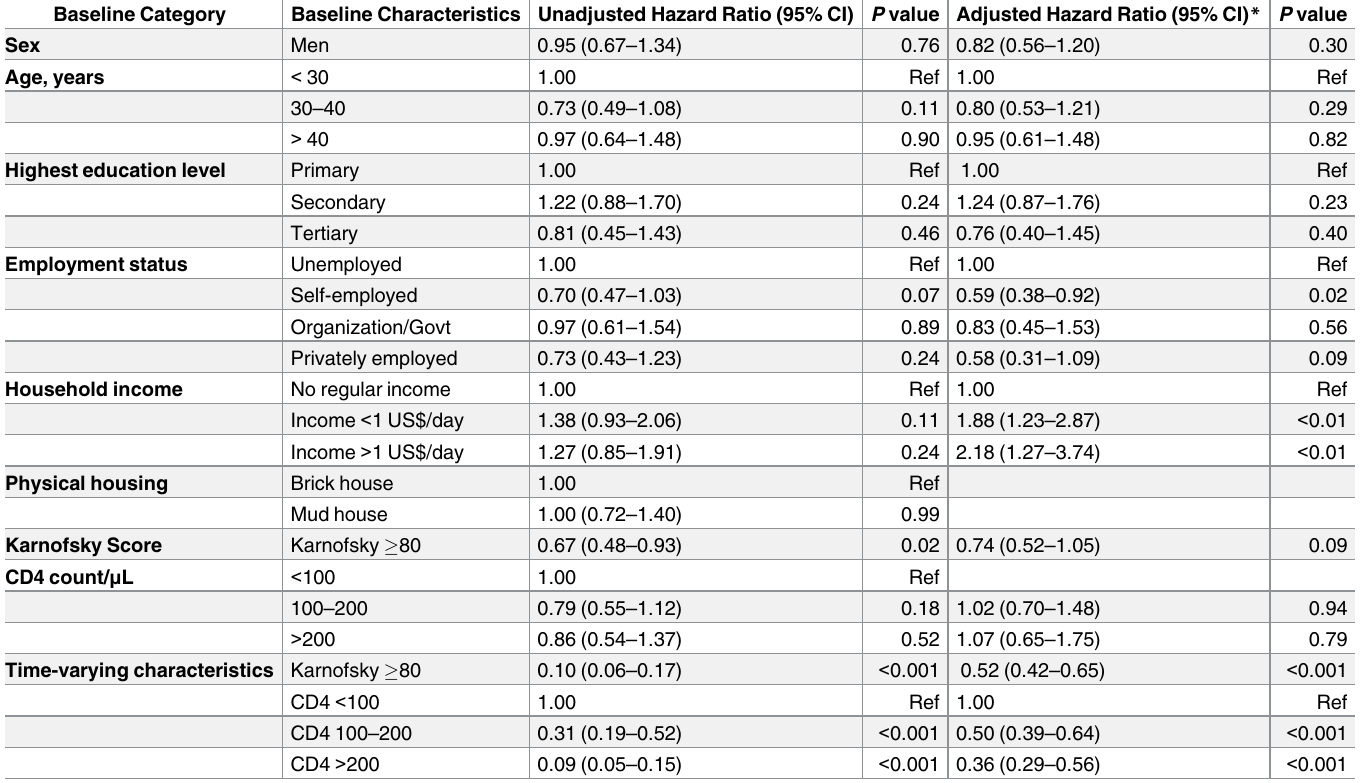
Table 2. Risk factors for 10-yearmortality or virologic failure (combined outcome) in a Ugandan cohort with baseline AIDS receiving ART (N = 472). Baseline